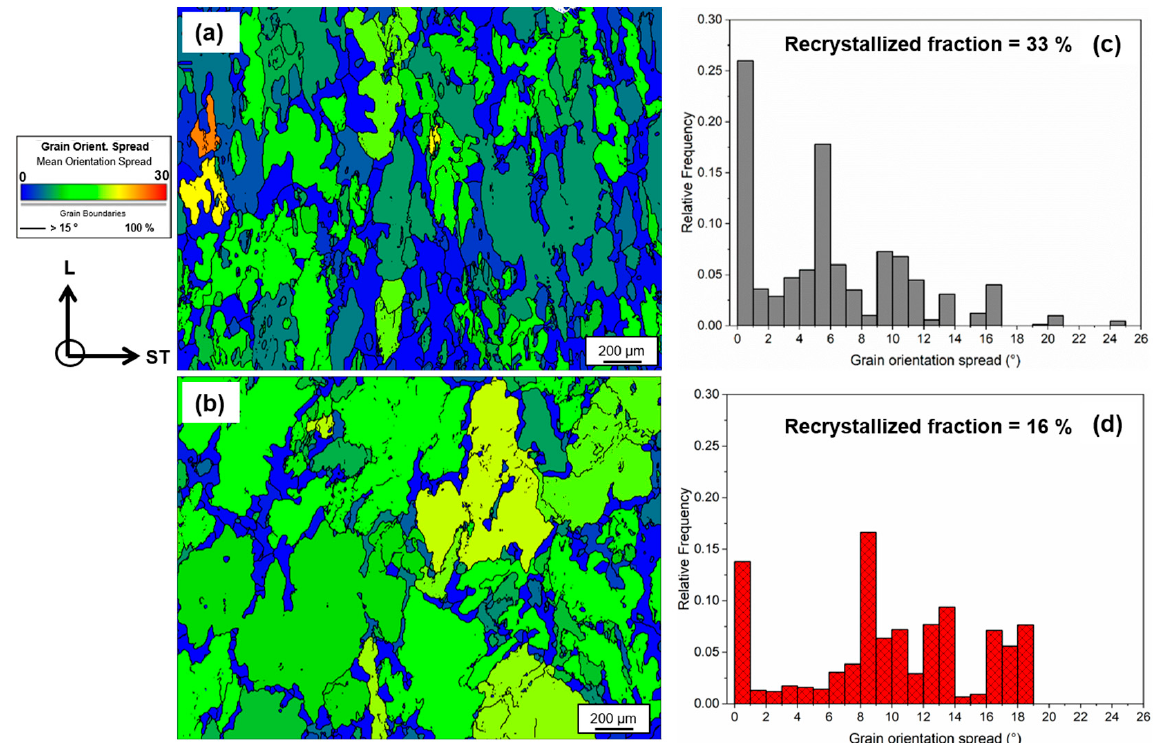
Figure 5. GOS maps of the alloys in T4 state: ( a ) 7449 and ( b ) 7449+Cr. The corresponding relative frequency distributions are shown for ( c ) 7449 and ( d ) 7449+Cr.